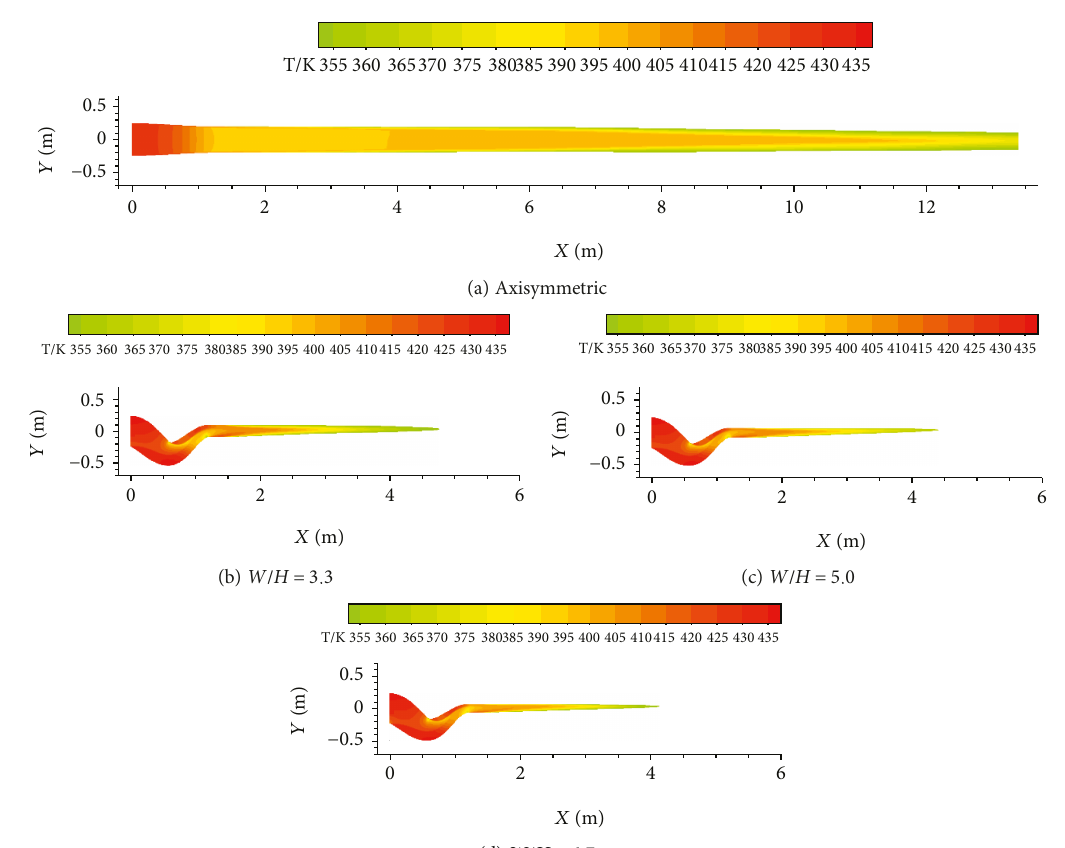
Figure 22: Static temperature on the symmetrical section varying W / H